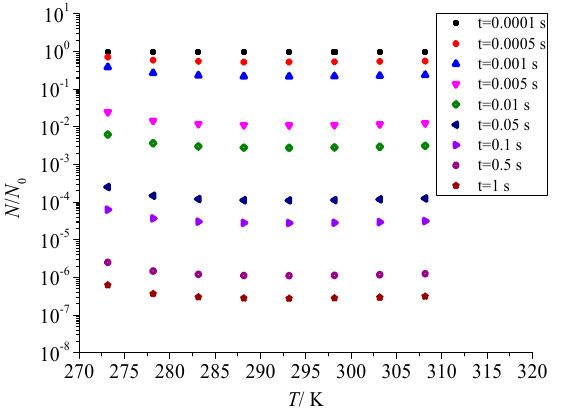
Figure 13. Effect of temperature on the total number of dimensionless particles.